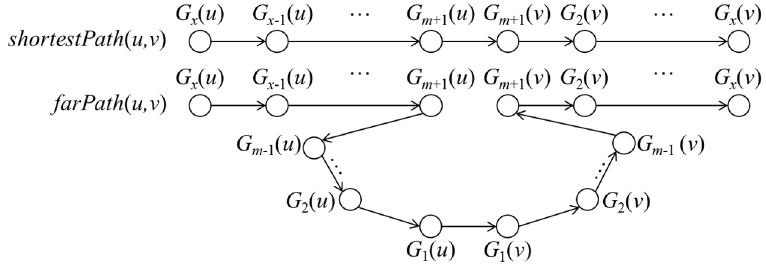
Figure A6. farPath ( u , v ) and shortestPath ( u , v ).